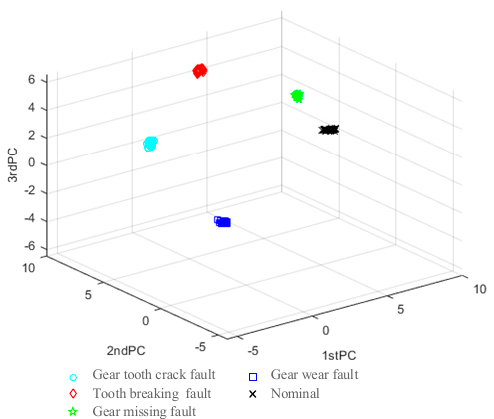
Figure 10. Clustering result of gear fault features under condition 4.